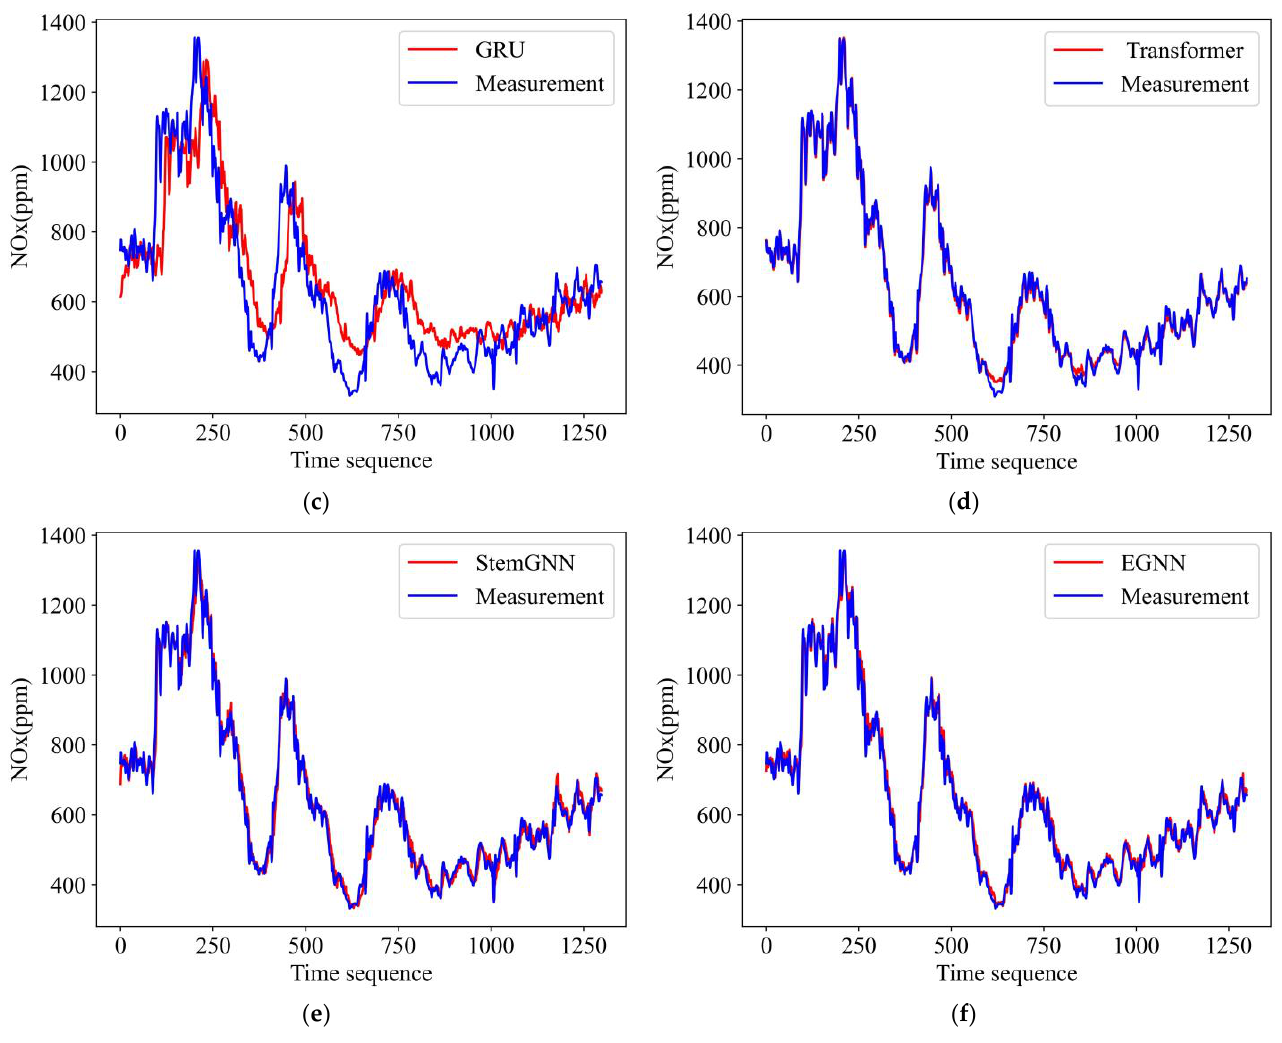
Figure 13. Single time step prediction results of the random condition. ( a ) Xgboost; ( b ) LSTM; ( c ) GRU; ( d ) Transformer; ( e ) StemGNN; ( f ) EGNN. Table 4. Single time step prediction results of six models .